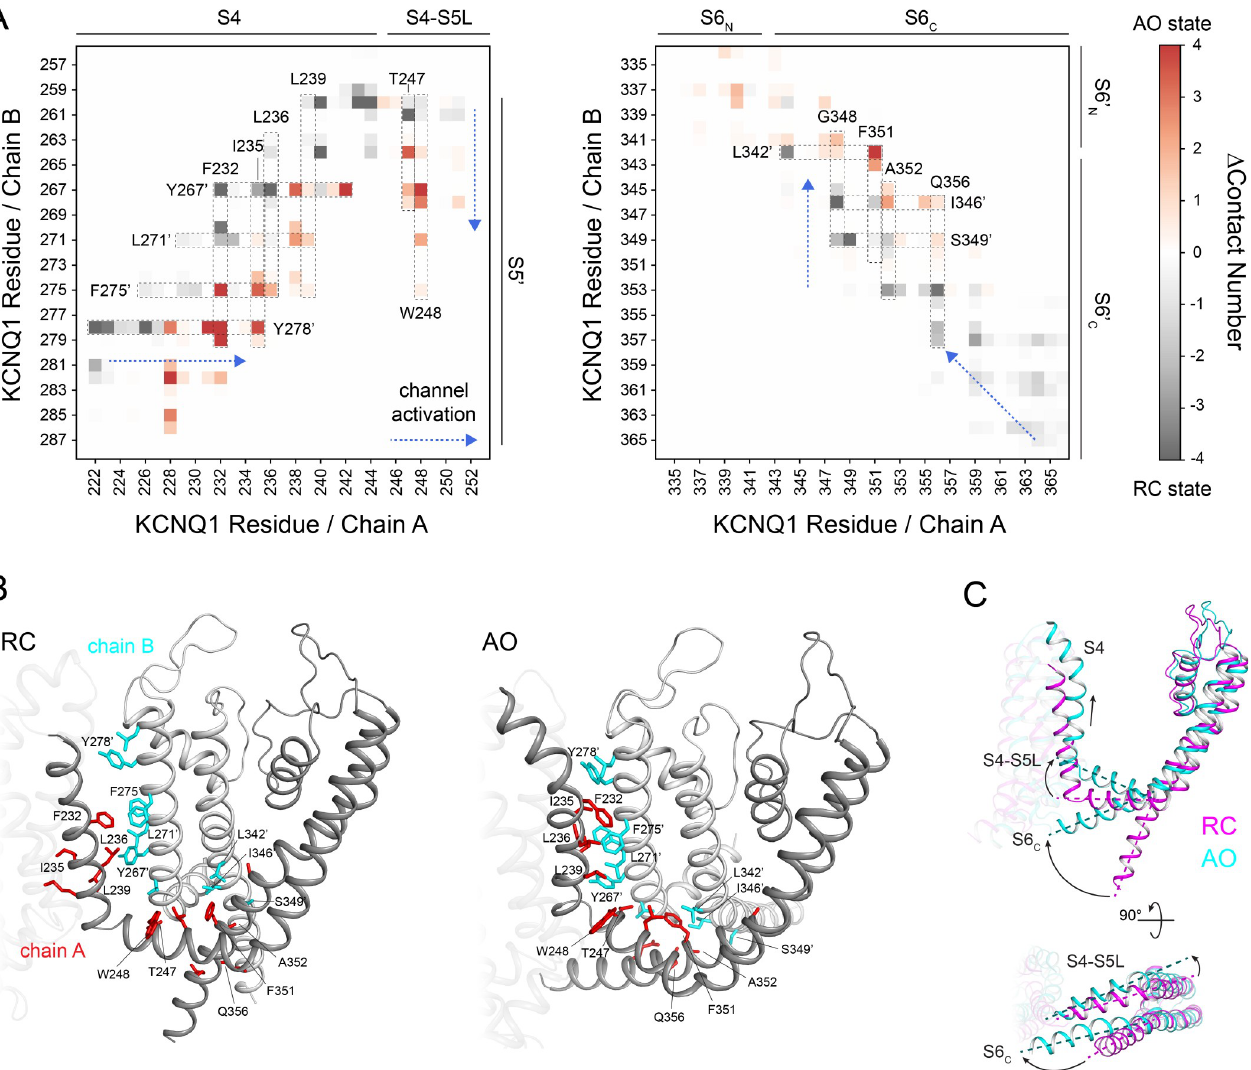
Fig 6. Conformational changes in KCNQ1 during channel activation inferred from modeling. ( A ) Change in average contact number between residues in two neighboring KCNQ1 chains A and B. The contact number was defined as number of heteroatom pairs within a 4 Å distance and averaged over the last 300 ns of MD and all four pairs of neighboring subunits in the KCNQ1 tetramer. The section of the contact matrix corresponding to the interface of S4 and S4-S5L with S5’ (left) and of two neighboring helices S6 and S6’ (right) is shown. A gray color means this contact is observed in the RC model whereas a red color denotes a contact formed in the AO model. Changes in specific residue contacts occurring while the channel transitions from the RC to the AO state are framed and labeled by their corresponding amino acid residue. The direction of the structural changes with channel activation is indicated by a blue arrow. ( B ) Cartoon representation of the inter-subunit interface in the RC (left) and AO (right) model, respectively. For clarity, only helices S4 to S6 are shown. Residues which are part of the inter-subunit interface and fall within regions of the contact matrix in ( A ) are depicted as sticks. Residues with drastic changes in their contact pattern as identified in ( A ) are labeled. ( C ) Movement of helix S4, S4-S5L, and S6 C during transition from the RC to AO state. Only one KCNQ1 subunit is displayed for clarity with the superimposition optimized for the pore domain. Helix axes are marked by dashed lines and the direction of their movement is indicated by arrows. S4-S5L moves upward to the extracellular side and tilts sideward allowing S6 C to kink.